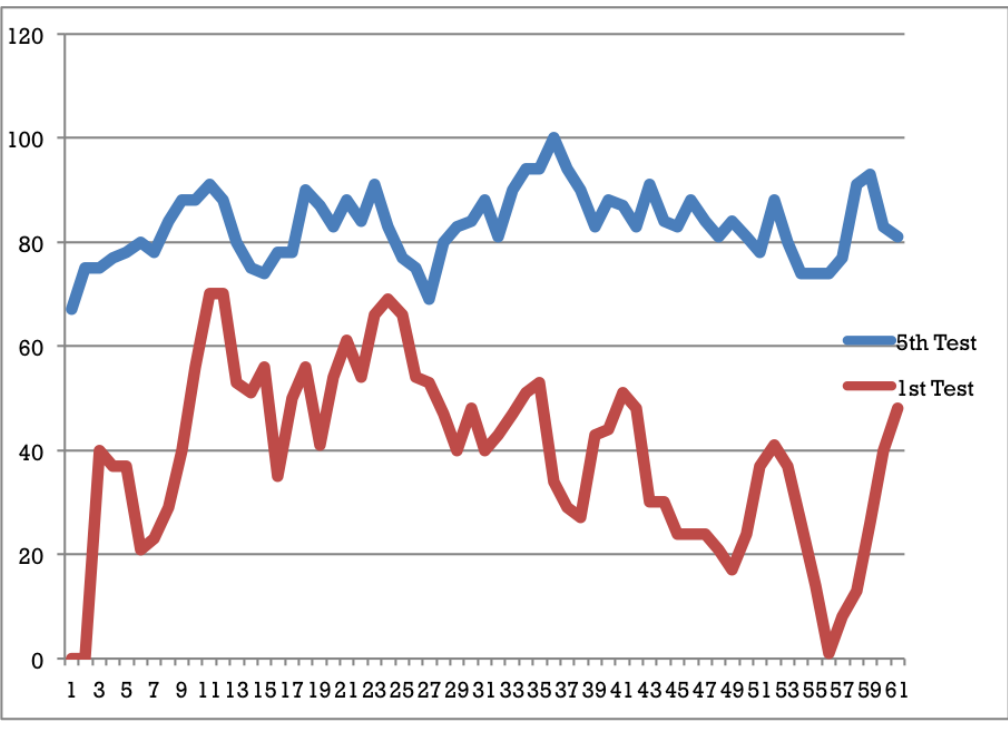
Figure 7: Attention level of User E during the in the first and last tests.